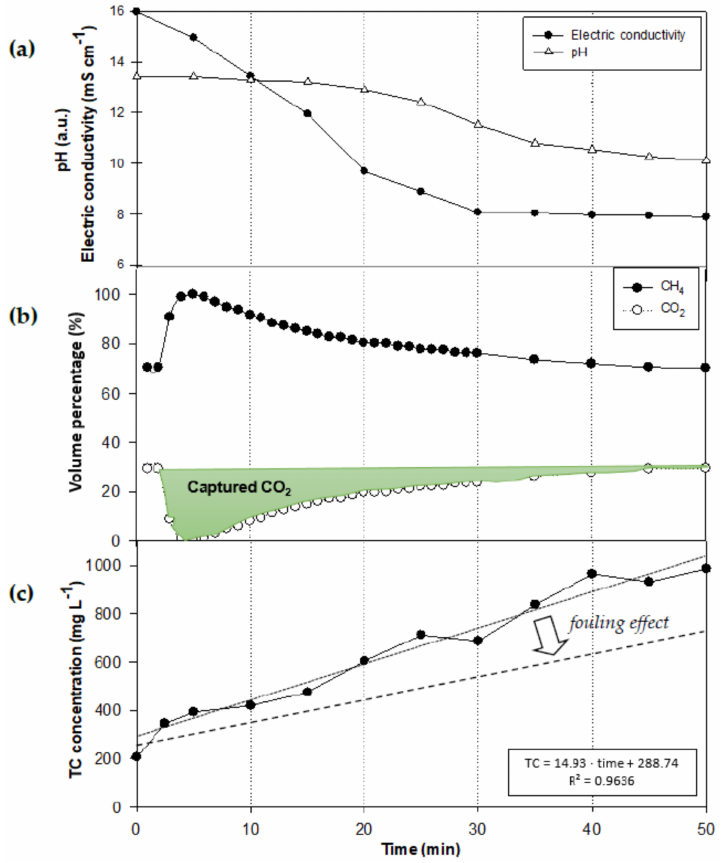
Figure 5. Example of CO 2 capture test. Sub-figures show the evolution in time of: ( a ) pH and electric conductivity of wastewater; ( b ) biogas effluent composition; ( c ) total carbon (TC) concentration of wastewater. Highlighted in green, the area corresponding to CO 2 captured in wastewater. A regression curve in sub-figure ( c ) shows that CO 2 transfer process follows linear dynamics (equation on the bottom right of figure). Membranes fouling reduces the CO 2 transfer